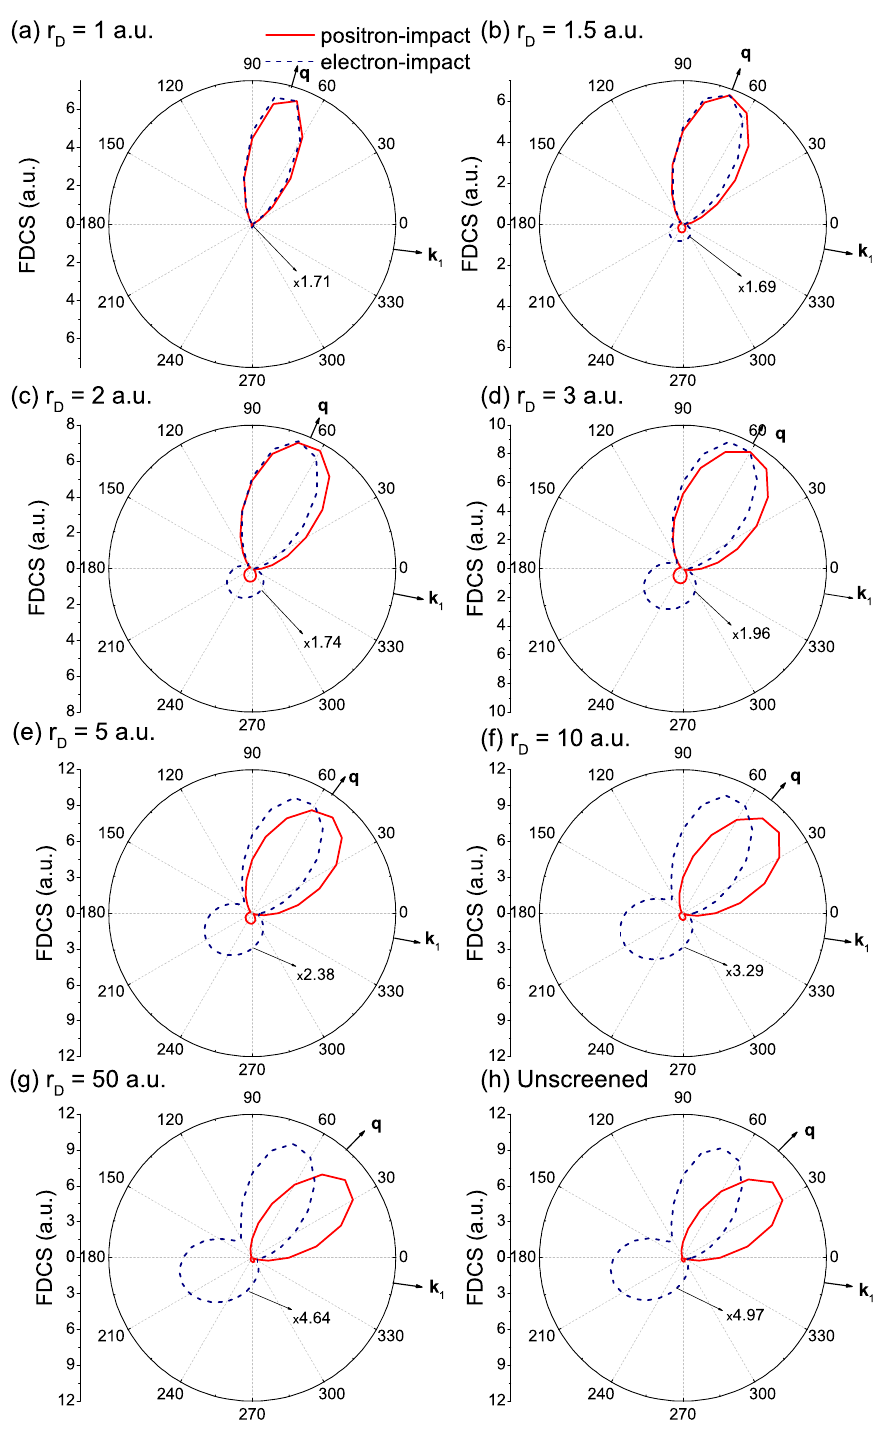
Figure 5. The same visualization as in Figure 4 but for θ 1 = − 10 ◦